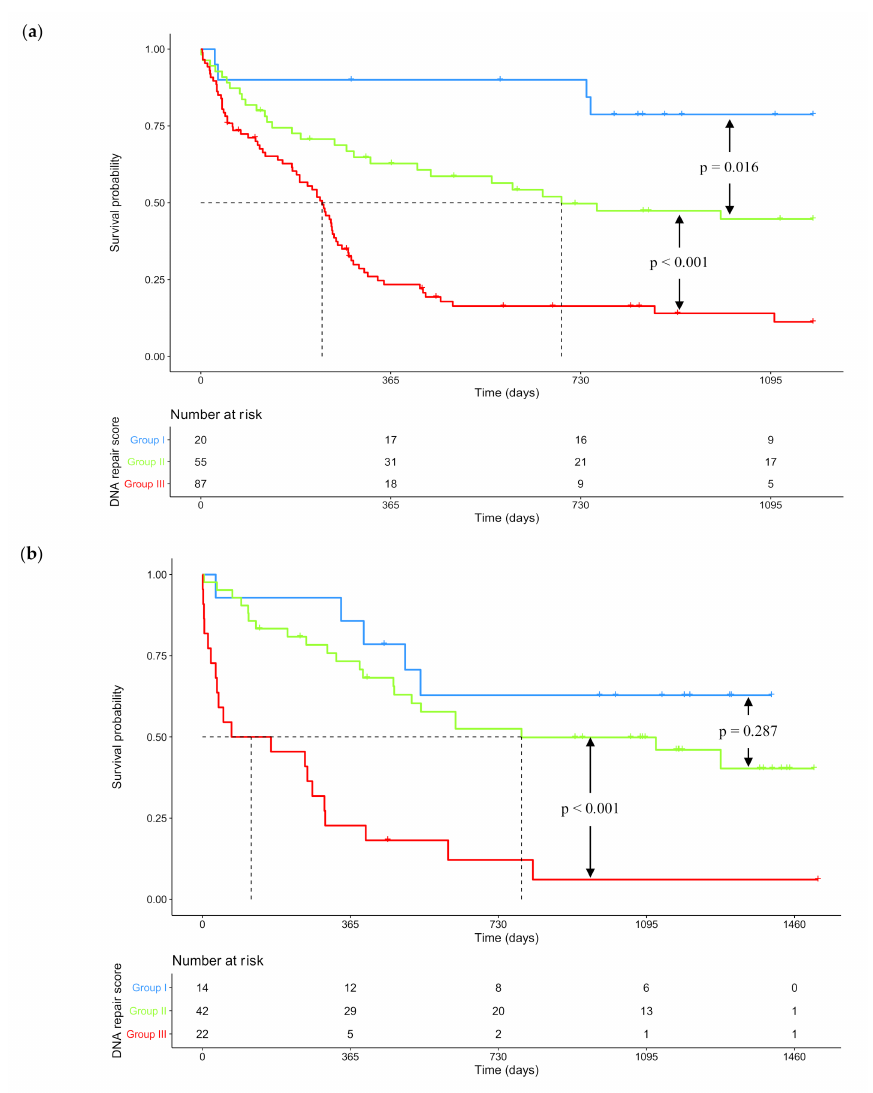
Figure 2. Kaplan–Meier survival curves according to risk stratification determined by DNA repair score. ( a ) Kaplan–Meier survival curve in the training cohort ( n = 162). Median OS was not reached (95% CI: NR-NR), 693 days (95% CI: 414–NR) and 233 days (95% CI: 184–260) respectively for